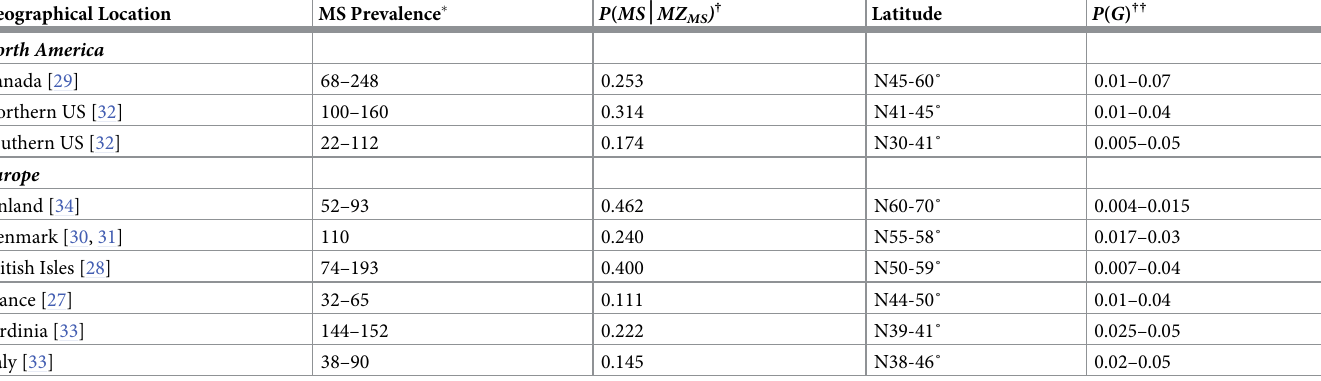
Table 4. MS prevalence, MZ -twin concordance { P ( MS │ MZ MS ) }, and “genetic susceptibility” { P ( G )}–for the upper solution ( see Text )–in different geographical